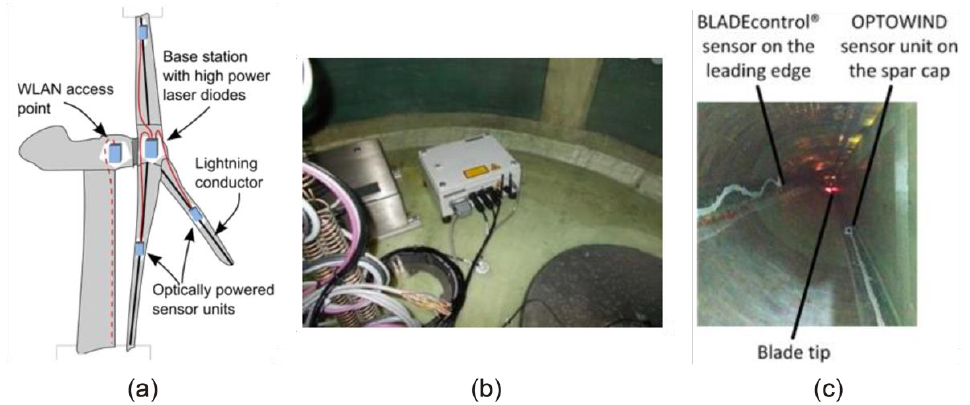
Figure 4. ( a ) Configuration of optically powered rotor blade condition monitoring system. Photographs of ( b ) base station placed in inside of hub of wind turbine and ( c ) inside of rotor blade [33].